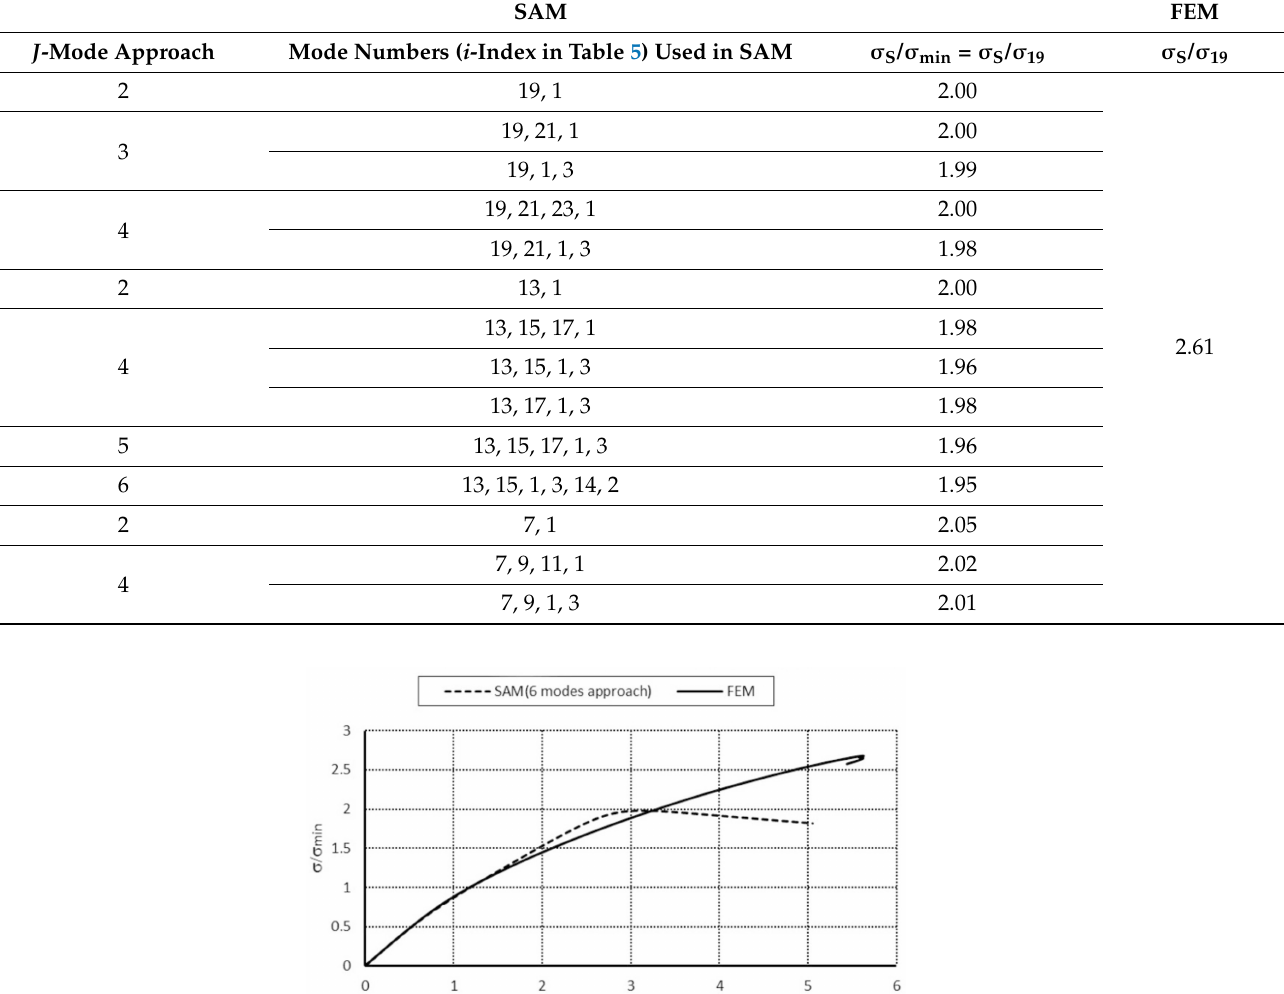
Table 6. Values of the dimensionless ultimate load-carrying capacity for the TH-channel of total length 225 mm (the semi-analytical method (SAM) and the finite element method (FEM) results).